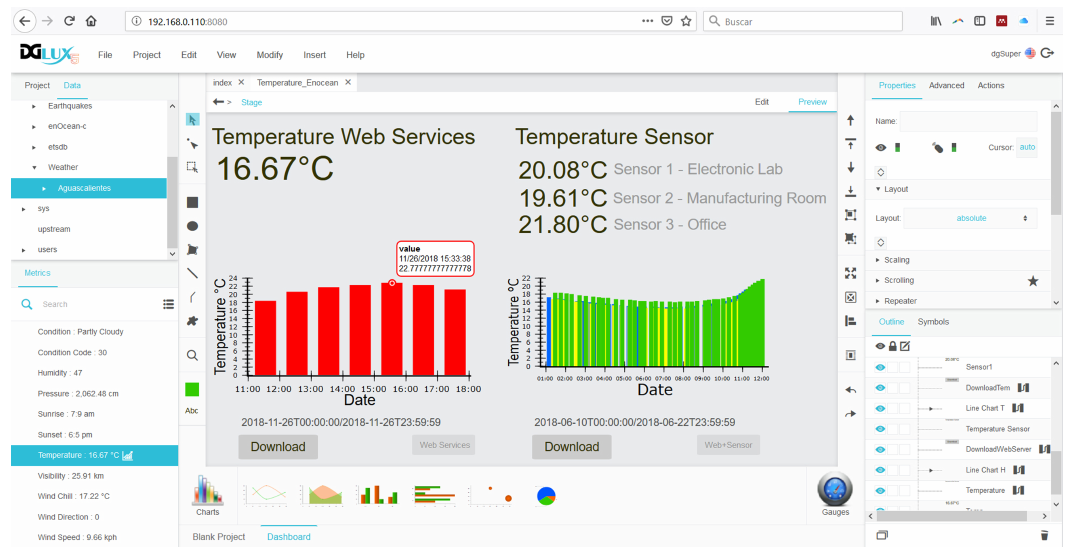
Figure 2. Snapshot of the front-end developer of DGLux5 ®program.